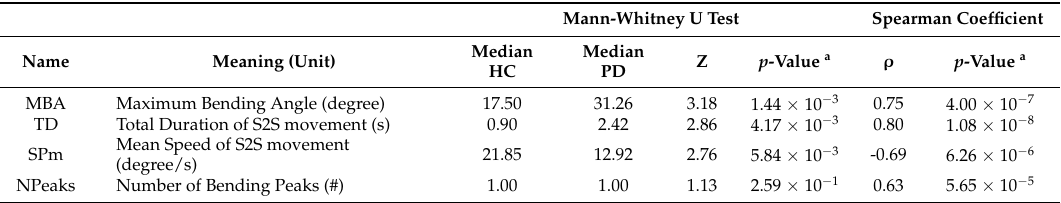
Table 6. Parameters of the AC task: discriminant power and correlation with UPDRS scores.